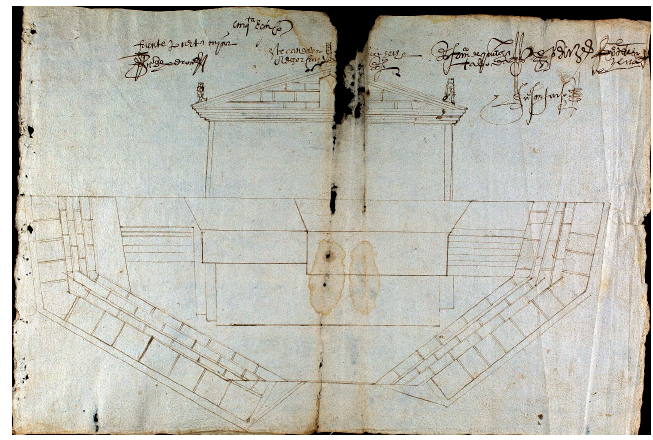
Figure 4. Drawings of the Porta Miñá Fountain, Gonzalo de la Bárcena, 1583. Provincial Historical Archive of Lugo: Maps, plans and drawings, No. 98.